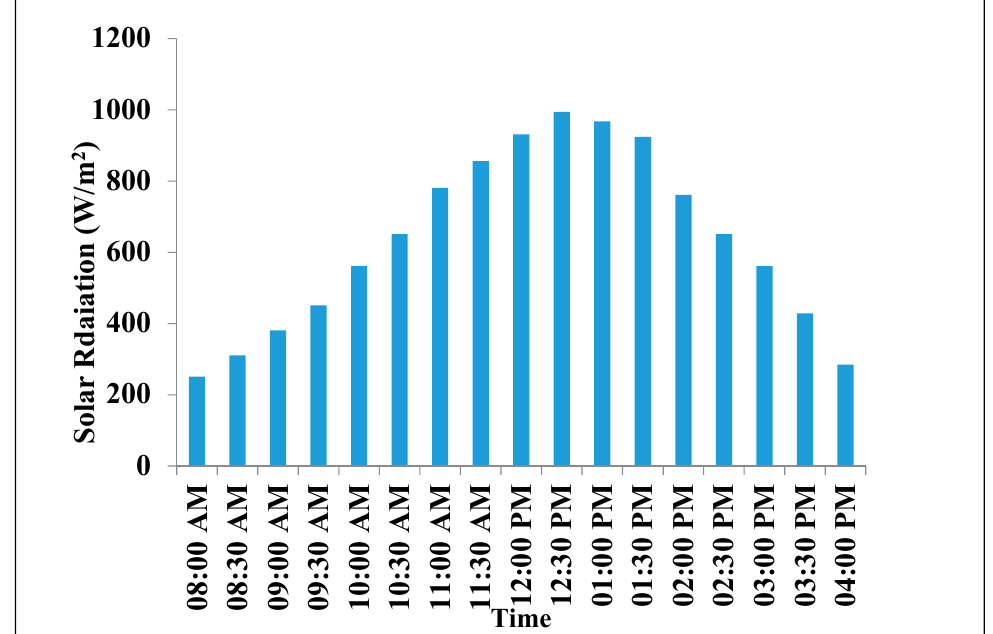
Figure 2. Variation of solar radiation during the day time of 15 May 2017 at Silchar.